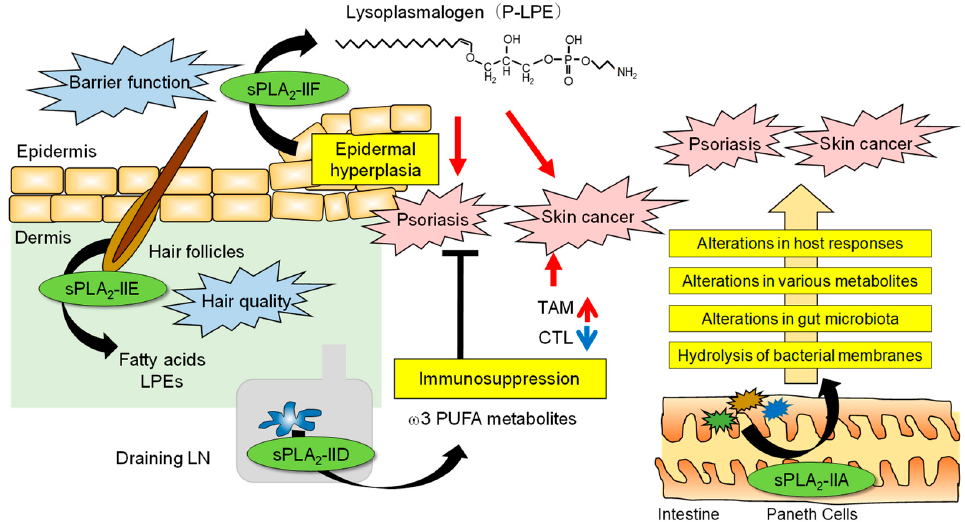
Figure 2. The roles of sPLA 2 s in skin homeostasis and disease. The skin is an organ that interfaces between the host and the external environment. The major sPLA 2 s expressed endogenously in mouse skin are sPLA 2 -IIF and sPLA 2 -IIE, the former in the epidermis and the latter in hair follicles, depending on the hair cycle. Following a psoriatic stimulus, sPLA 2 -IIF is induced in epidermal keratinocytes by Th17 cytokines derived from T and Th17 cells and preferentially hydrolyzes plas- malogen to give rise to P-LPE, which in turn promotes epidermal hyperplasia and inflammation. In contrast, sPLA 2 -IID blocks Th17 immunity in the draining LN through the production of ω 3 PUFA metabolites, thereby putting a break on psoriasis. In the case of skin cancer, P-LPE produced by epidermal sPLA 2 -IIF promotes hypergrowth of skin cancer without affecting its incidence, while + CD8 + cytotoxic T cells ω 3 PUFA metabolites produced by sPLA 2 -IID in the LN decrease IFN-g (CTLs) and increase M2-like tumor-associated macrophages (TAMs). As such, sPLA 2 -IID reduces anti-tumor immunity and ultimately facilitates tumor formation and growth. In the intestinal lumen, sPLA 2 -IIA secreted from Paneth cells acts as an antimicrobial protein to shape the gut microbiota, thereby secondarily affecting host responses, including psoriasis and skin